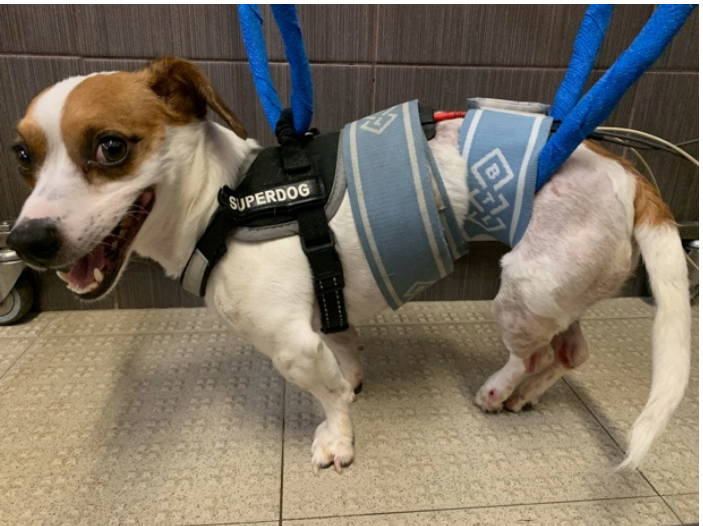
Figure 4. Transcutaneous electrical spinal cord stimulation. One electrode of each canal at the T11 to T12 region and the others at the L7–S1